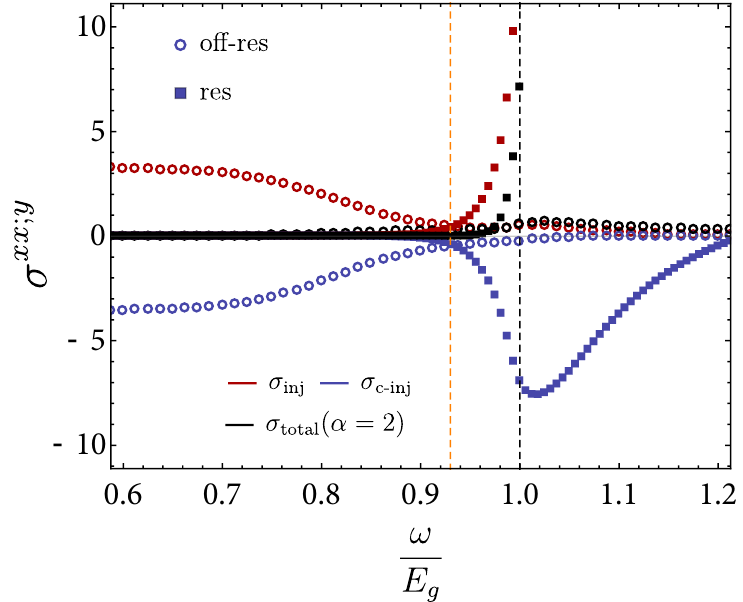
Figure 2: Decomposition of the total conductivity, as a function of ω E − 1 model in App. C. The dashed gray line indicates the position of the gap. Filled squares (of any color) denote resonant contributions, empty circles (of any color) denote off-resonant contributions. In red, we plot the injection current contribution, Eq. (25). In blue, we plot the counter-terms, which are the Eq. (26). Black denotes the total optical conductivity. Throughout, the chemical potential is placed within the gap, i.e., µ = 0, and Eq. (27) vanishes